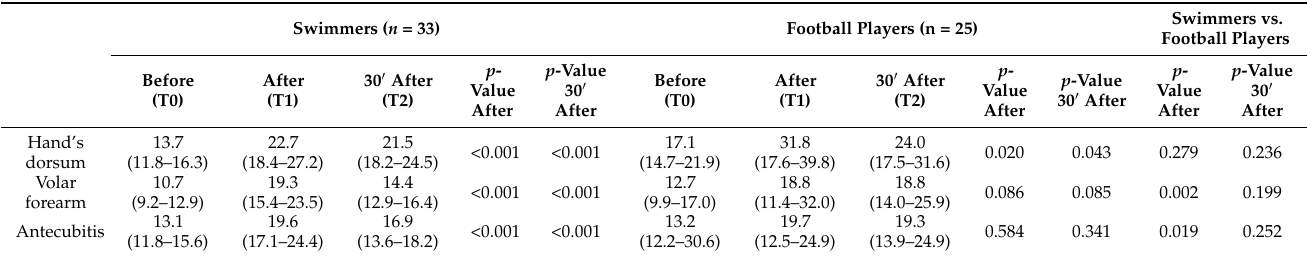
Table 2. Transepidermal water loss values (g/m 2 /h) before, immediately, and 30 min after training.